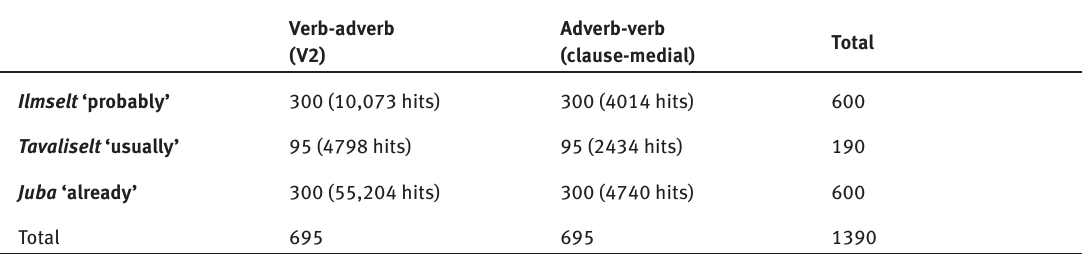
Table 1: The composition of the dataset (the numbers in parentheses reflect the total number of results returned by each